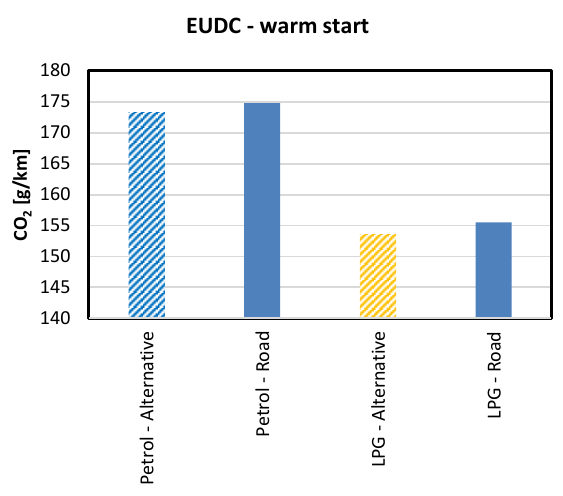
Fig. 5. Impact of resistance forces on CO 2 emissions for EUDC phase